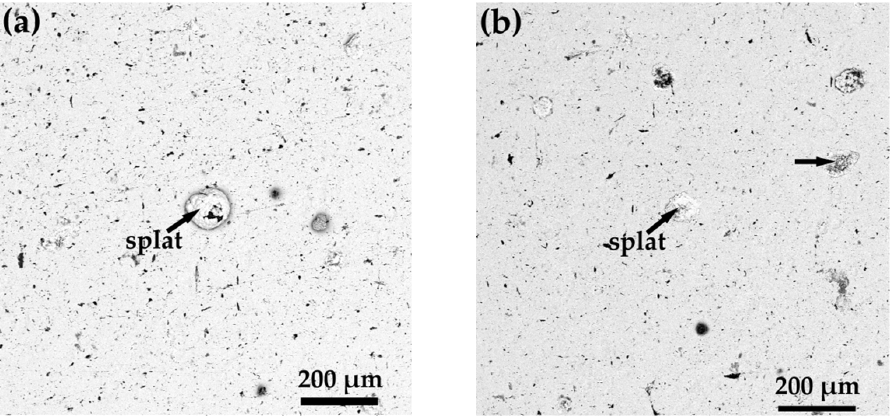
Figure 10. Morphologies of Ni-coated Al particles deposited onto a Q235 steel substrate at an accel- erating gas temperature of ( a ) 200 °C and ( b ) 400 °C .